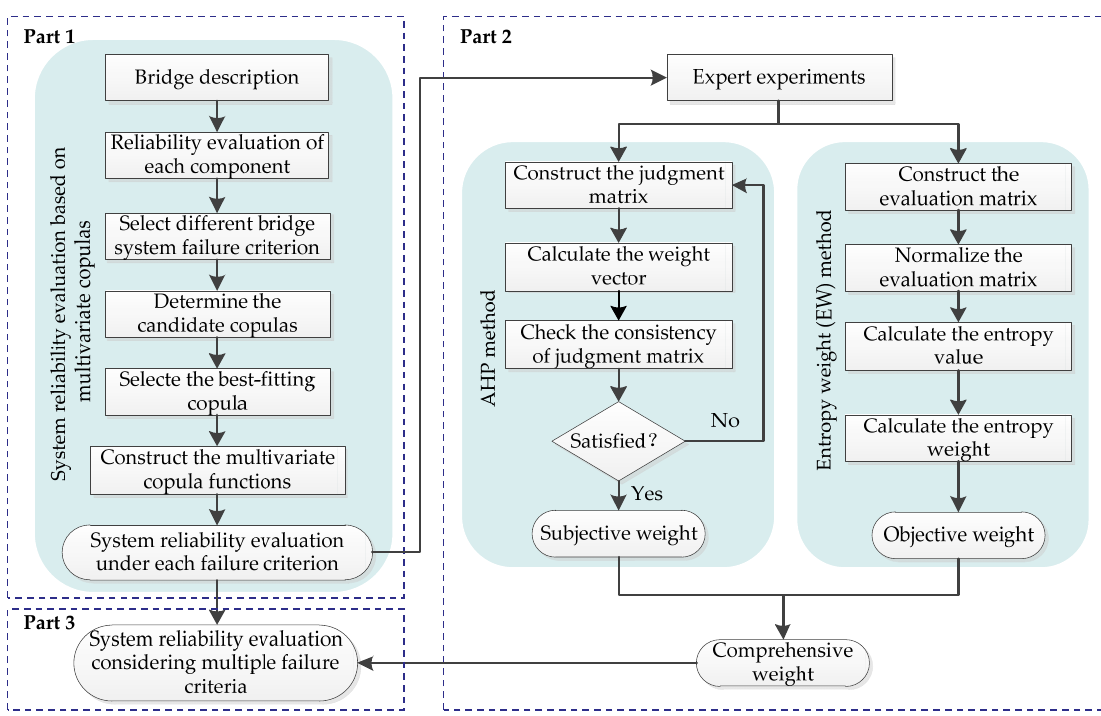
Figure 1. The flowchart of a system reliability evaluation that considers multiple failure criteria. AHP: Analytic hierarchy process.